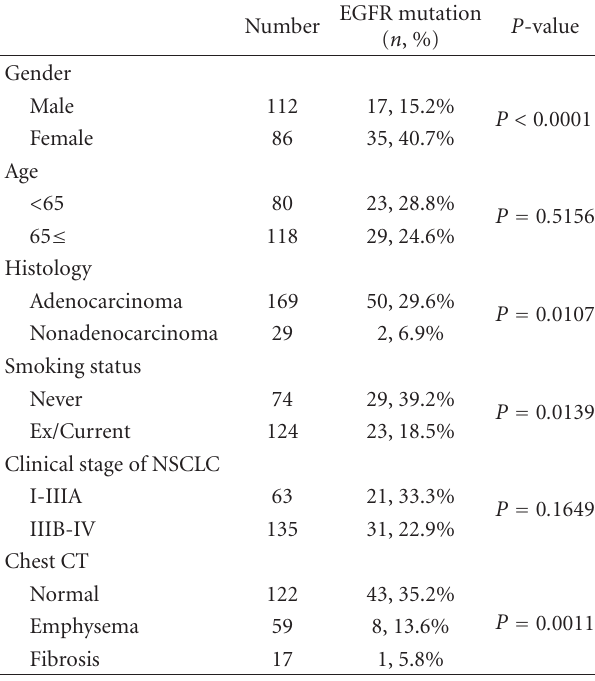
Table 1: Patient characteristics NSCLC: nonsmall cell lung cancer: LCNEC; large cell neuroendocrine carcinoma.